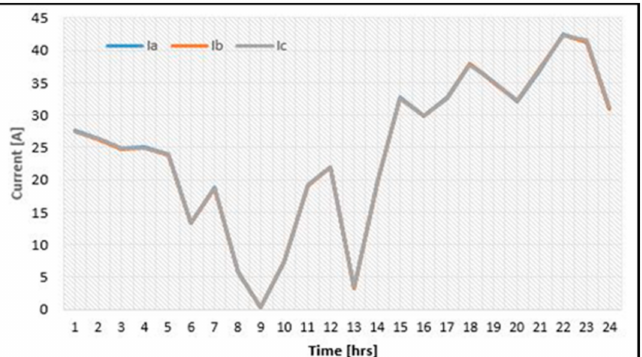
Figure 16. The aggregated phase currents at the level of the CCP obtained with the proposed methodology, H-PLB case.